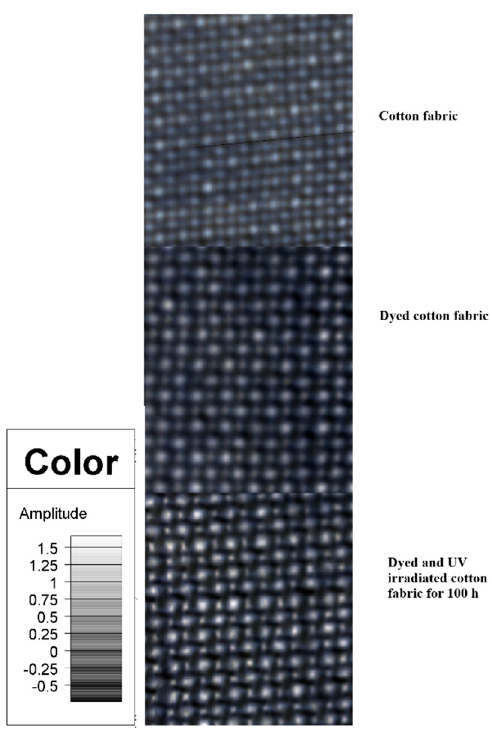
Figure 15. PLS-DA model for non dyed cotton fabric, dyed cotton fabric, and dyed and UV irradiated cotton fabric for 100 h.